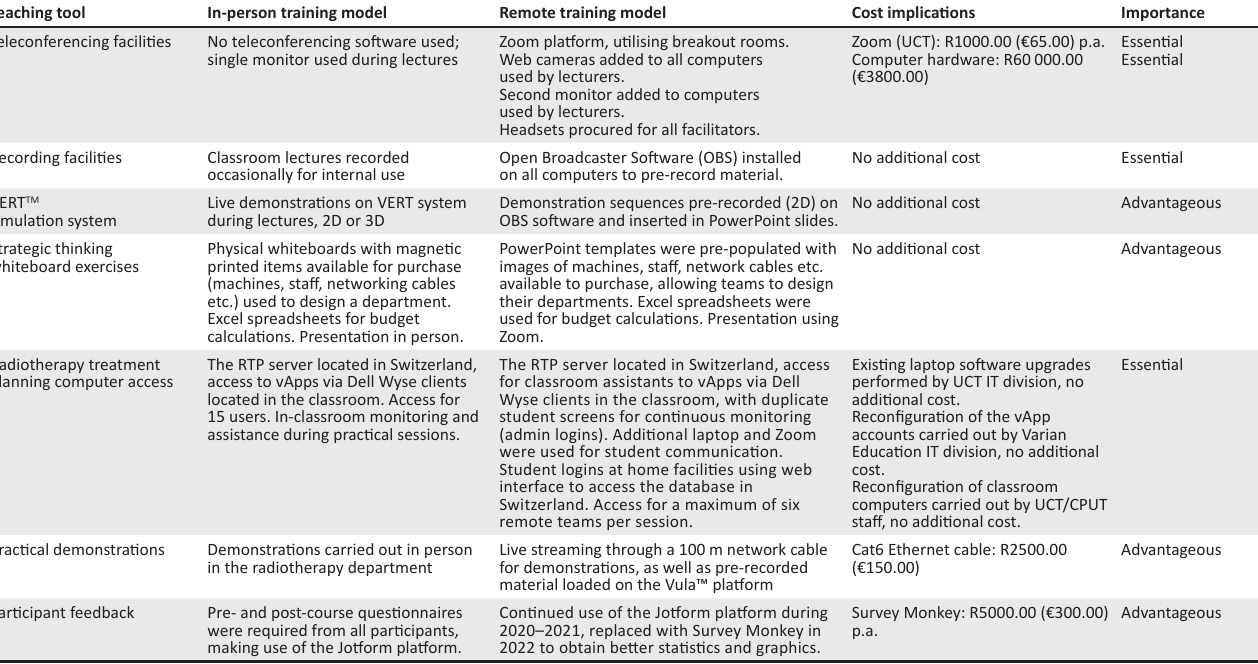
TABLE 1: Computer-related modifications to allow for remote teaching during the COVID-19 pandemic. Teaching